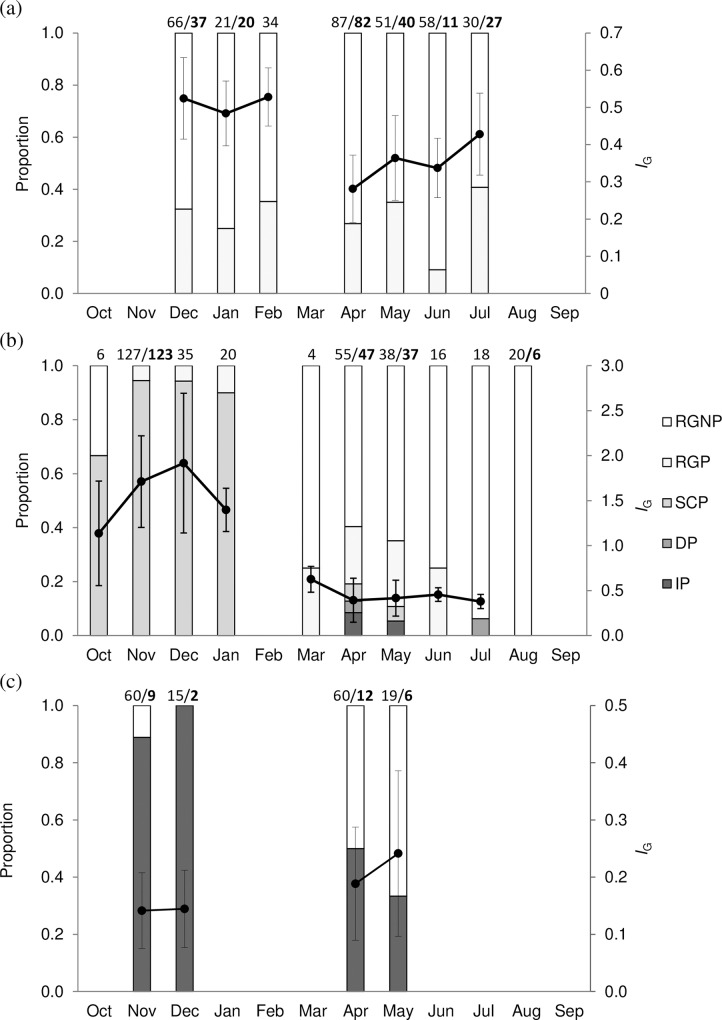
Monthly mean gonadosomatic index and proportion of female albacore with different ovarian developmental phases at different latitudinal areas in the western Indian Ocean.(a) north of 10°S (region A), (b) at latitudes 10–30°S (regions B and C) and (c) south of 30°S (region D) in the western Indian Ocean. IG: gonadosomatic index, IP: immature phase, DP: developing phase, SCP: spawning capable phase, RGP: regressing phase and RGNP: regenerating phase. Numbers above the bars indicate the numbers of fish analyzed for IG and for histological development (in bold) when different. Bars represent standard deviation.